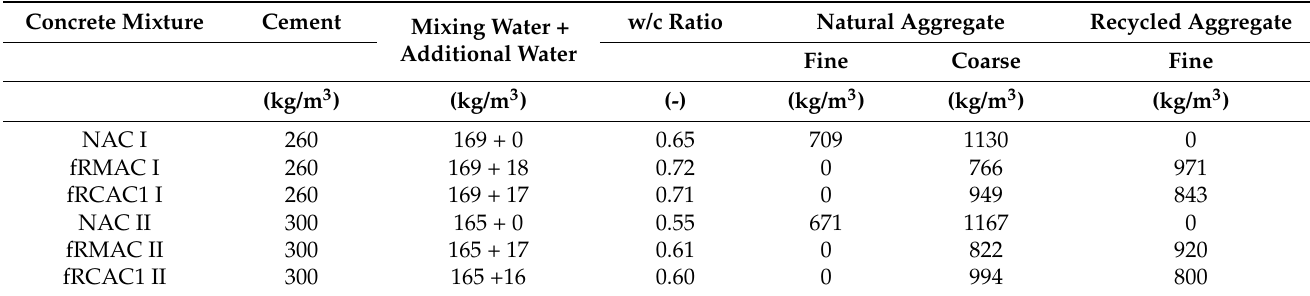
Table 2. Concrete mix proportion, per cubic meter.